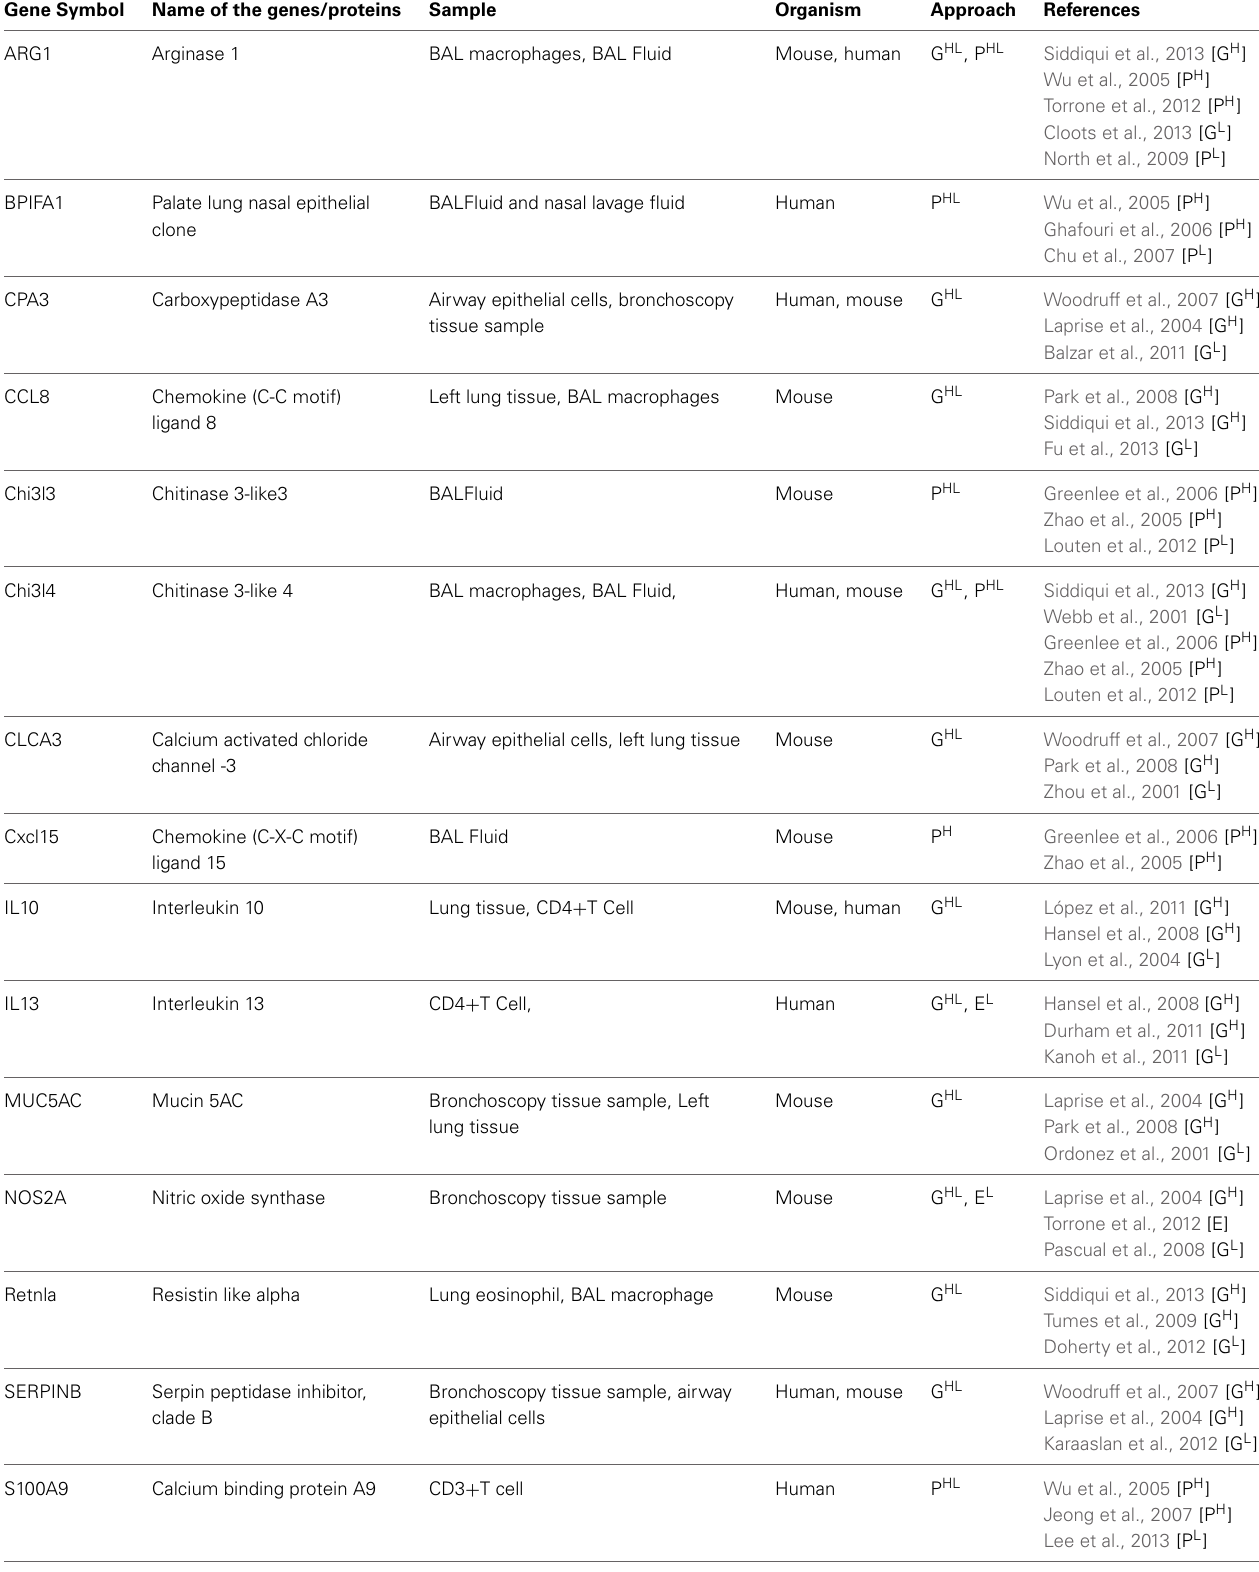
Table 1 | List of asthma biomarkers cited in two or more times in Database of Allergy and Asthma Biomarkers (DAAB). Gene